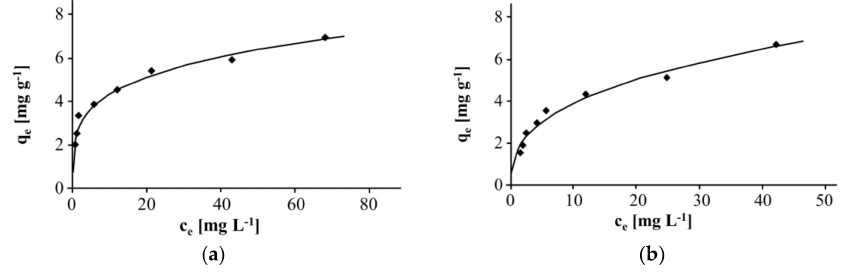
Figure 5. Freundlich isotherm for the adsorption of Zn(II) on Taurit: ( a ) distilled water; ( b ) tap water.